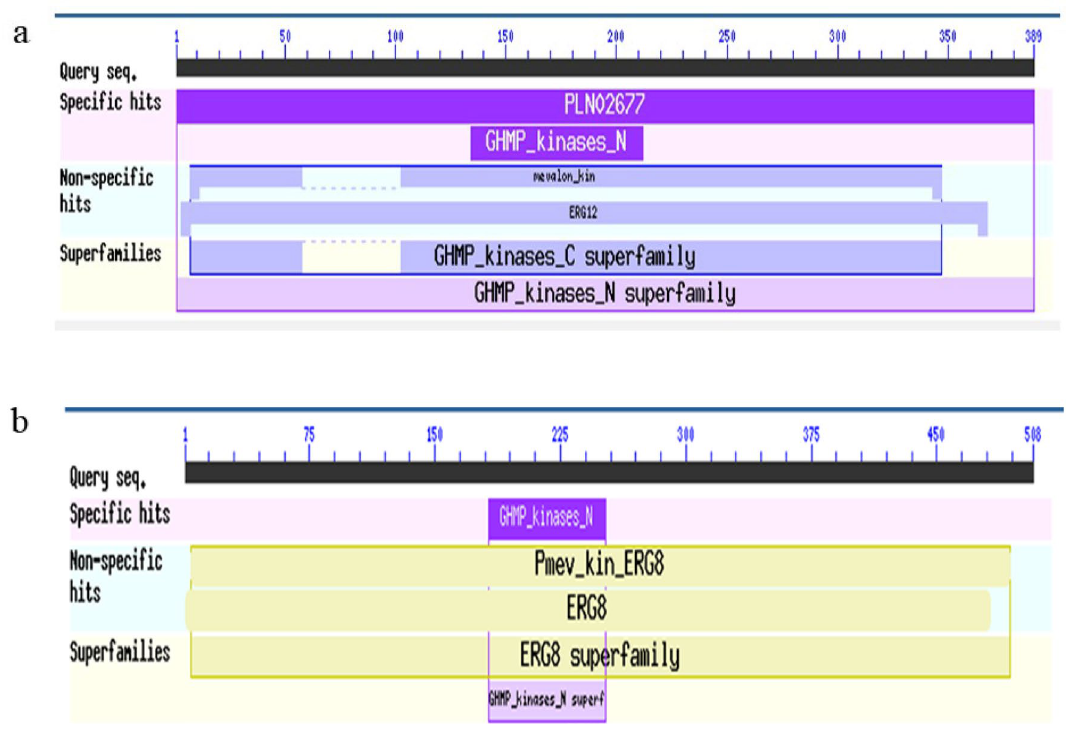
Figure 2. Conserved domains of SaMK ( a ) and SaPMK ( b ) proteins in Santalum album